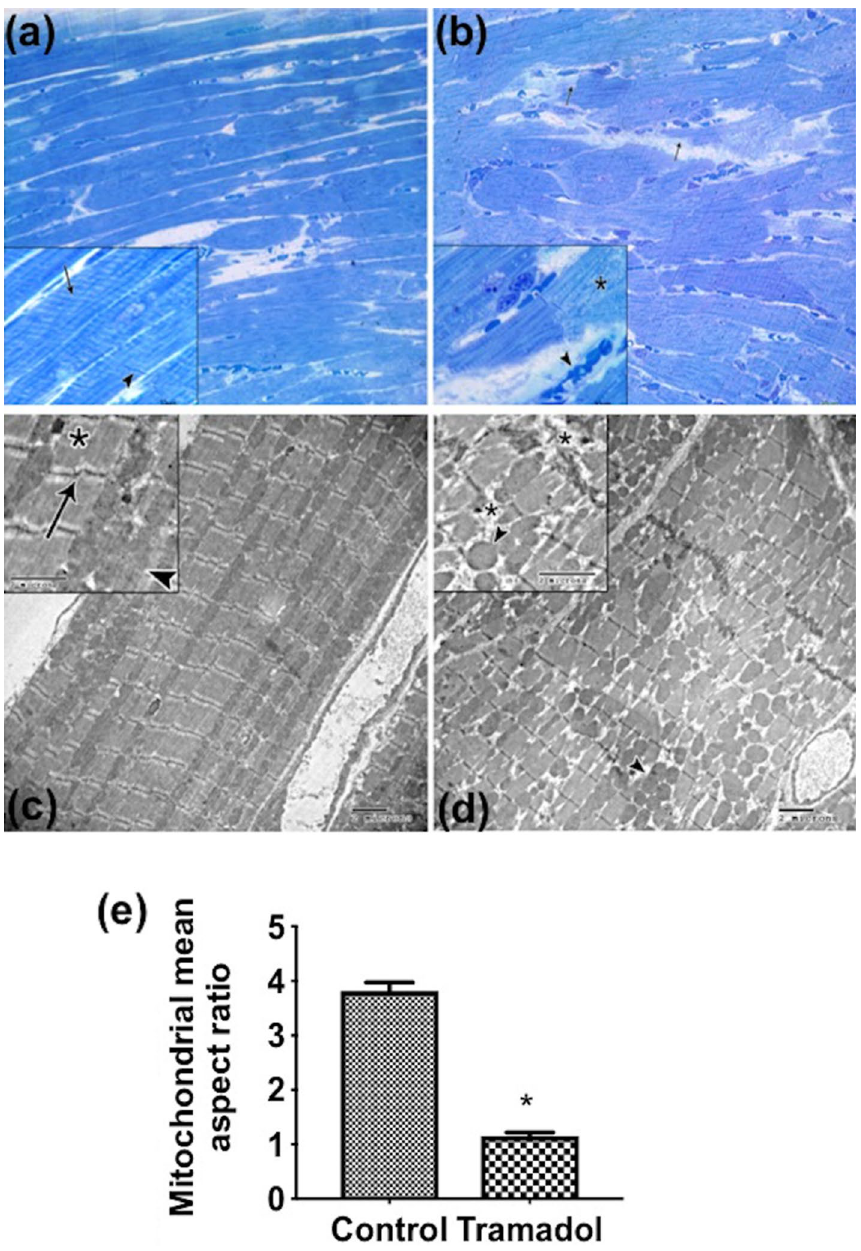
Figure 3. Semithin sections of longitudinally cardiac muscle fibers stained with toluidine blue (×400; insets ×1000). ( a ) Control group showing branching and anatomizing muscle fibers with cross striation along the length of muscle fibers (arrow in inset). Intercalated disks also appear as dark lines (arrowhead in inset). ( b ) tramadol treated group showing disruption in muscle fibers (arrows) and pale stain areas with the disappearance of the intercalated disc (asterisk in inset). Congested blood vessels are also detected (arrowhead in inset). Transmission electron micrographs of cardiac muscle fibers (×3600; insets ×4800) ( c ) The sarcoplasm of control cardiomyocytes composed of longitudinal arrays of cylindrical myofibrils. Each myofibril has myofilaments arranged in sarcomeres (asterisk in inset) that extended between two Z lines (arrows in inset). Elongated mitochondria are regularly arranged in rows between the myofibrils (arrowheads in inset) and often mitochondrion extent the full length of a sarcomere. ( d ) cardiomyocytes from tramadol treated group have areas with disorganization of sarcomeres, fragmentation of myofilaments (asterisk in inset), and accumulated groups of circular rather than elongated mitochondria are seen (arrowheads). ( e ) Aspect ratio. n = 10. Values represent mean ± SEM. *p < 0.05 for control versus